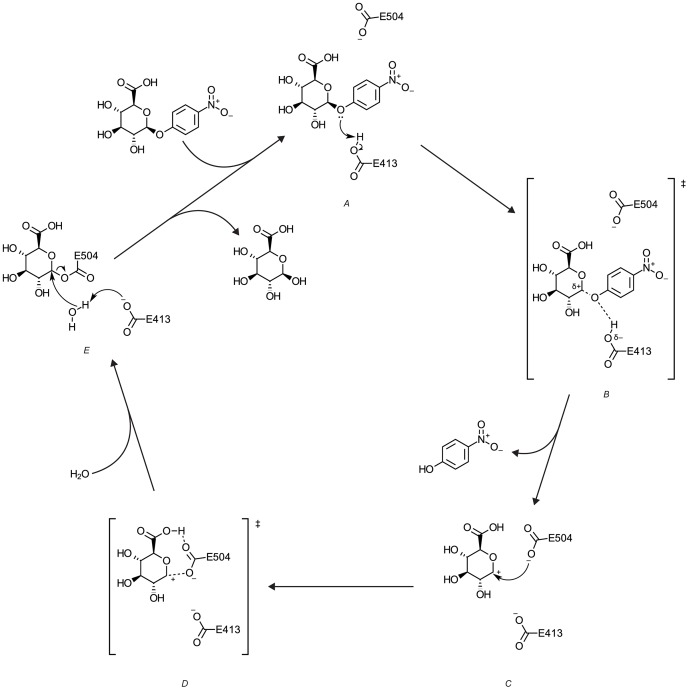
Proposed catalytic reaction mechanism of GUS from in vacuo QM calculations (Text S1).In the first step, substrate binds to the active site of GUS. Next, the lone pair on the glycosidic bond attacks the proton of E413 (A). This forms a hypothetical TS (B) with the glycosidic bond partially broken. The glycosidic bond is fully cleaved, releasing para-nitrophenolate and forming a carbocation intermediate (C). The electrons on the anionic E504 then attack the anomeric carbon, resulting in a hypothetical TS (D) where the carbocation and E504 are electrostatically attractive. A covalent intermediate (E) is formed between the carbohydrate moiety of pNP-GLU and E504. Presumably, in the next step, the basic E413 attacks a proton of a water molecule. The resulting hydroxide anion attacks the anomeric carbon to yield the product of the reaction. The two catalytic residues are regenerated for further turnover.